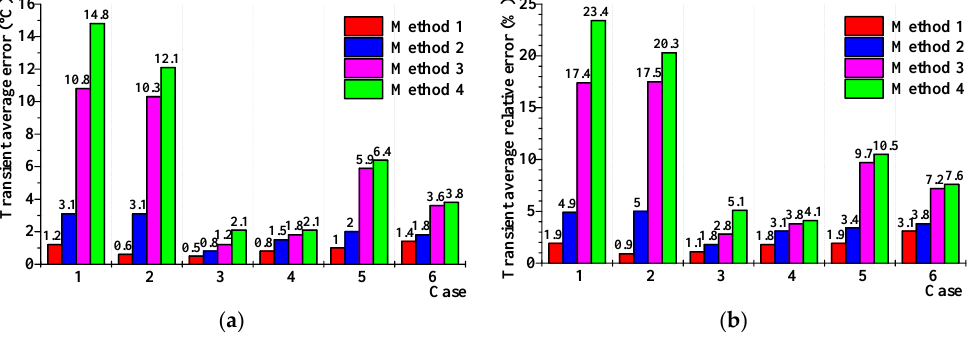
Figure 10. Calculation errors of transient conductor-temperatures based on different radial position temperatures: ( a ) average errors and ( b ) average relative errors.